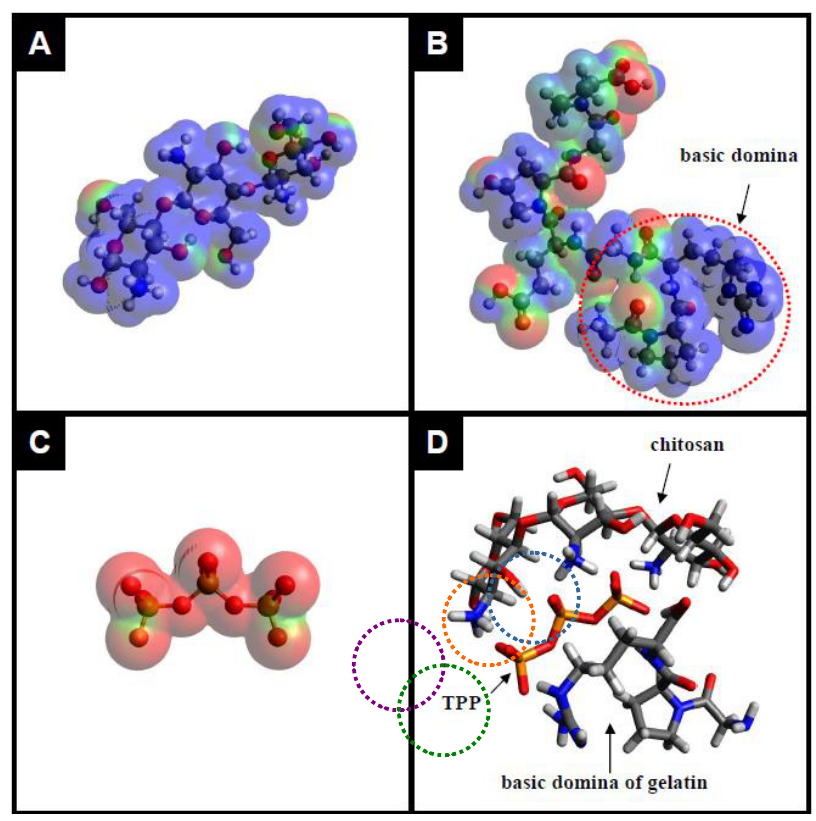
Figure 2. The electrostatic potential maps of chitosan ( A ), gelatin ( B ), TPP ( C ) and their electroststic interactions ( D ), showing positively charged regions in blue and negatively charged regions in red, were mapping by the Avogadro